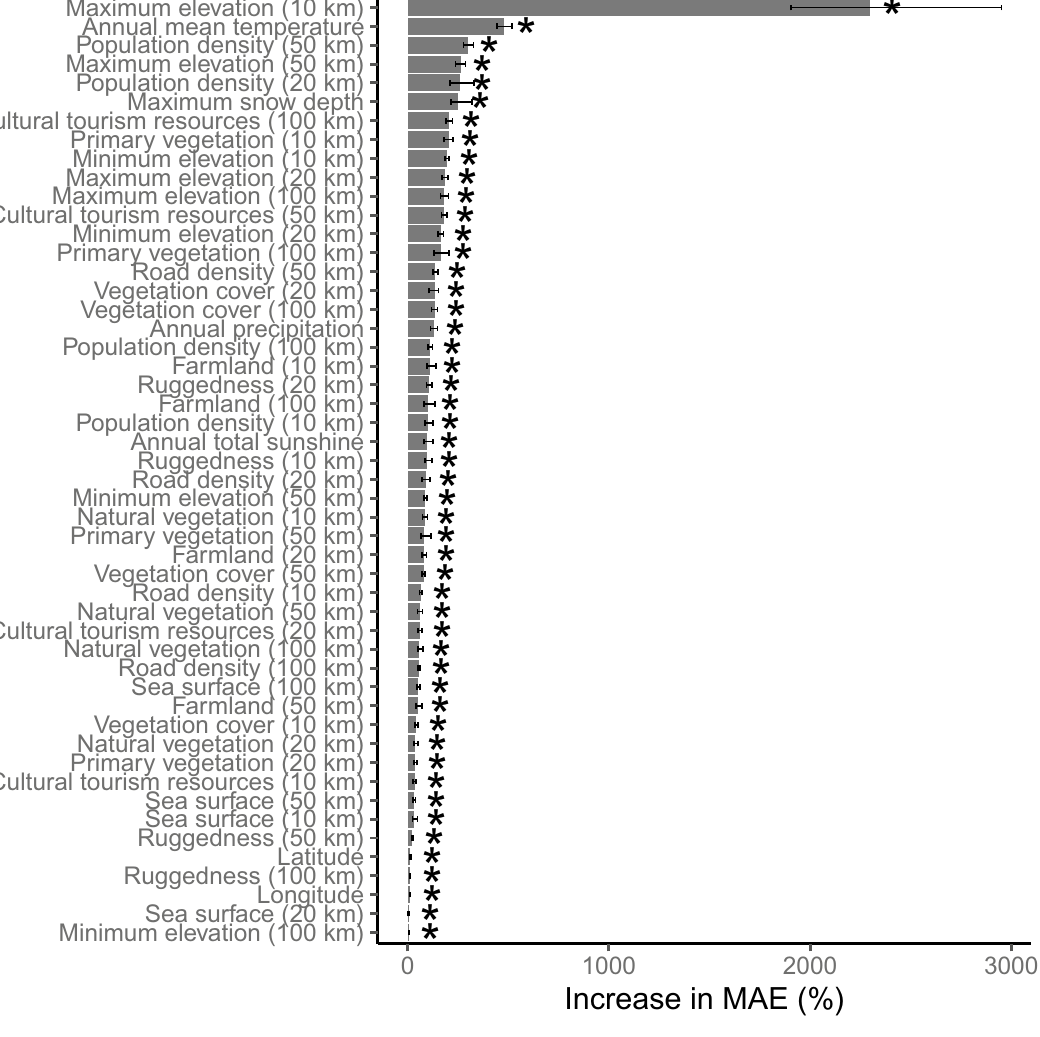
Figure 2. Importance of explanatory variables for total number of hiking records. The bar indicates 95% interval after 100 permutations. Values with an asterisk are statistically significant at p < 0.05. The values in parentheses are the spatial scale (distance from the center of each grid,